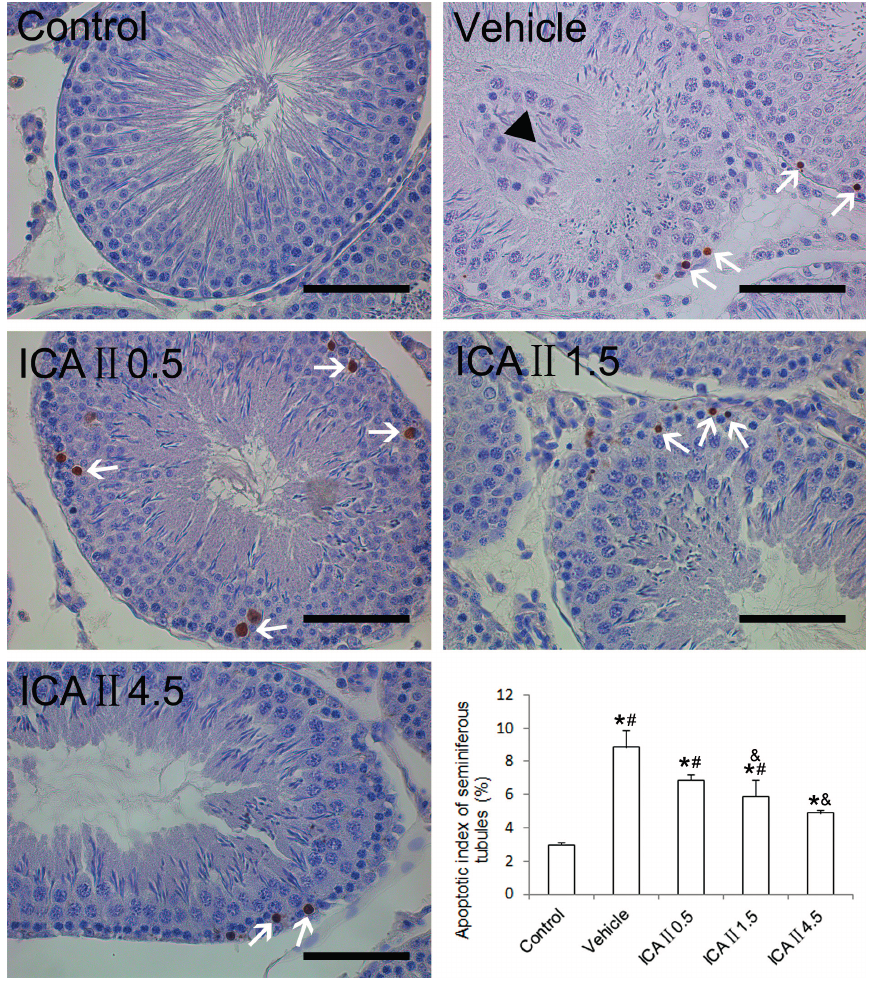
Figure 5. Representative TUNEL staining of the seminiferous tubules. Brown-stained cells are undergoing apoptosis (white arrows). The black triangle represents the deciduous cells in the lumen of seminiferous tubule. Seminiferous tubules containing two or more TUNEL-positive cells are positive tubules of apoptosis. AI is calculated as the ratio of the positive tubules to total tubules. Quantitative data of AI are shown in the bar chart on the lower right corner. 400×. * p < 0.05 compared with the control group; & p < 0.05 compared with the vehicle group; # p < 0.05 compared with the ICAII4.5 group. Scale bar = 50 μ